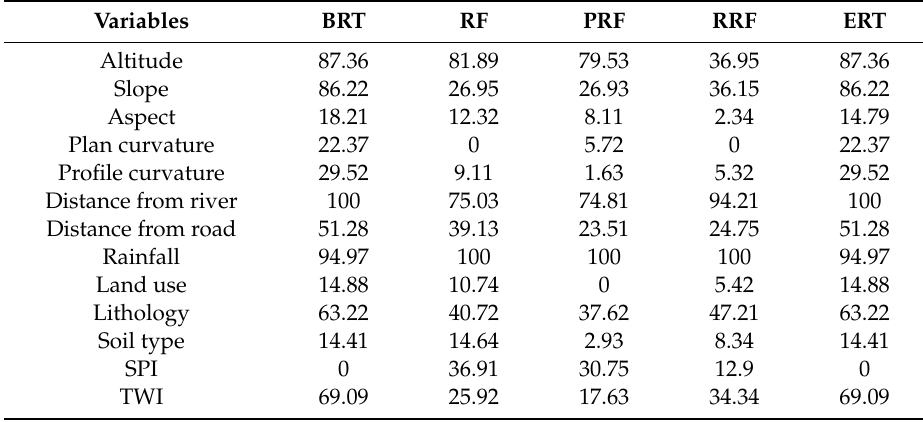
Table 4. Variable importance